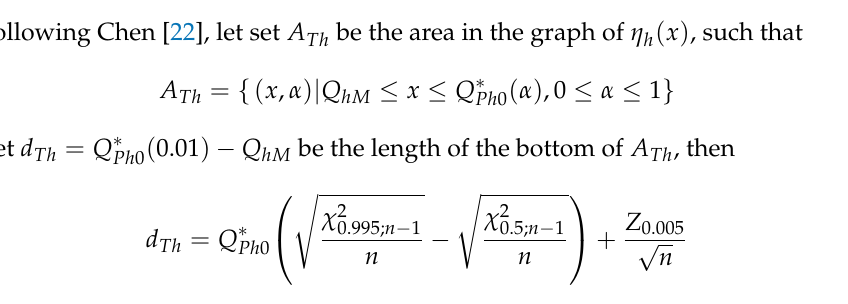
Figure 1. The diagram of membership function η h ( x ) with vertical line x = C (cid:48)